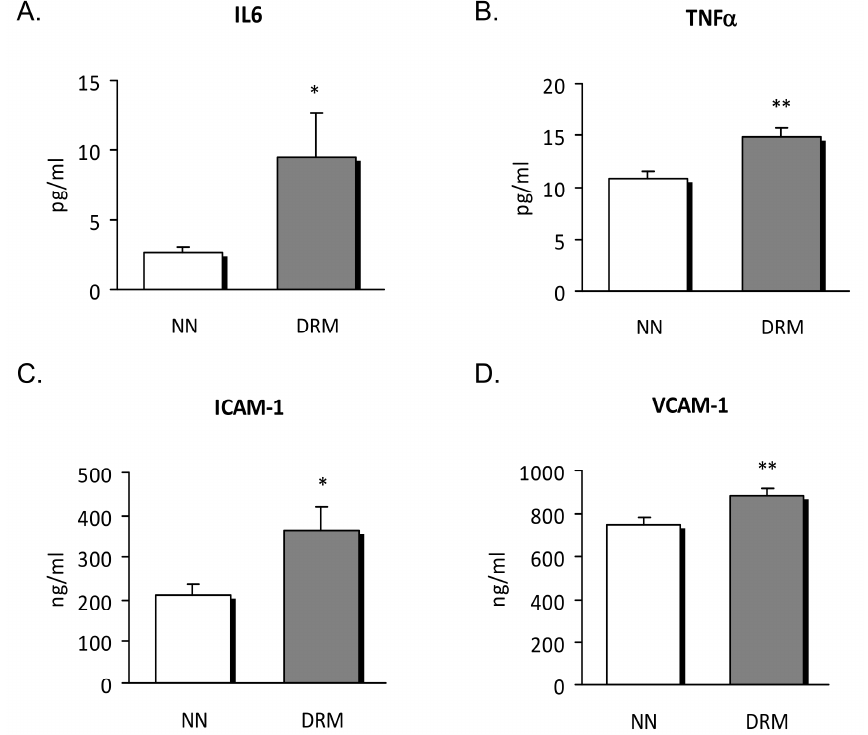
Figure 1. Serum levels of cytokines and soluble adhesion molecules from NN and DRM subjects. ( A ) IL6 levels measured as pg/ml. ( B ) TNF α levels measured as pg/ml. ( C ) ICAM-1 levels measured as ng/mL. ( D ) VCAM-1 levels measured as ng/ml. * p < 0.05 and ** p < 0.01 vs. NN group using an unpaired t-test. NN: Normonutrition; DRM: Disease-related malnutrition.